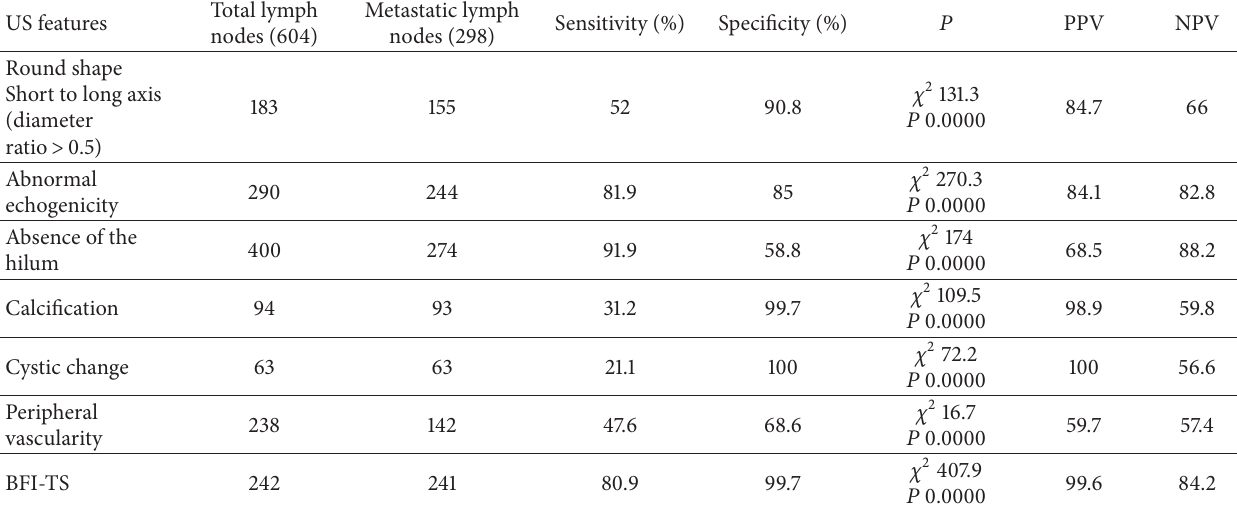
Table 1: The diagnostic performance of sonographic criteria for metastatic lymph nodes in 83 patients with papillary thyroid